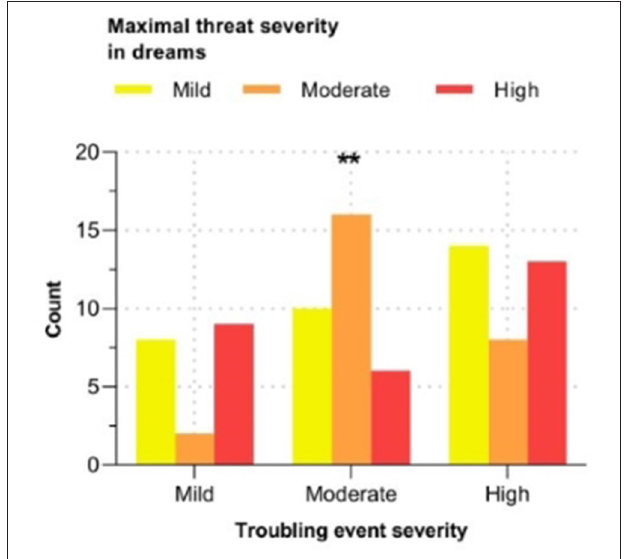
FIGURE 4 | Associations between the severity of a recent troubling event and severity of oneiric threats. The values are expressed as count. N = 125. ** p <